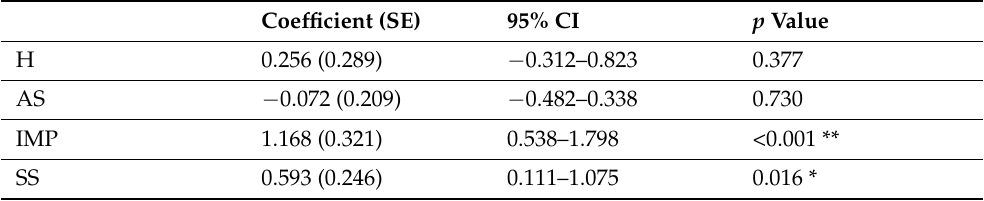
Table 4. Associations between personality groups at baseline and number of new traumas experienced across adolescence. Coefficient (SE) 95% CI p Value H 0.256